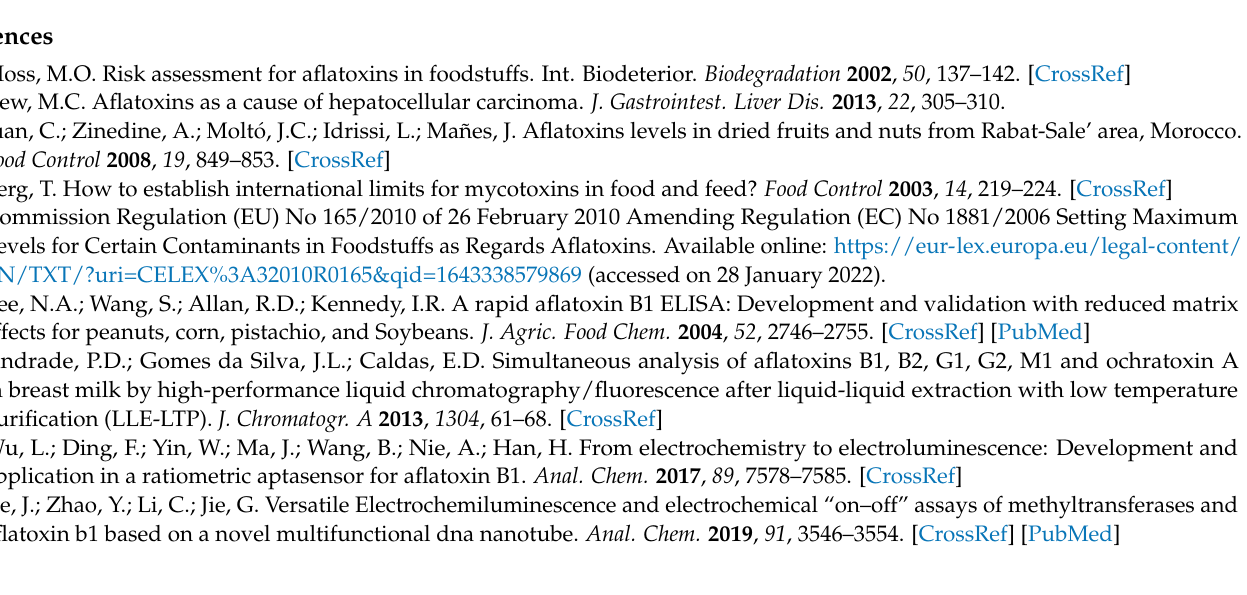
leads; Figure S2: Examination of pH effects; Figure S3: Examination of the optimal enrichment time and the recovery with different elution solvents; Figure S4. Analysis of standard samples using our ionization setup; Table S1: List of the existing methods for analysis of AFB1 and related mycotoxins; Table S2: List of the existing SPME approaches for the analysis of